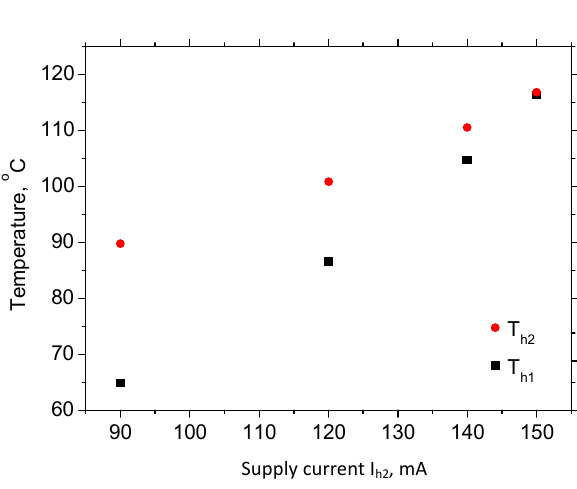
Figure 5. Temperature of both heaters versus the current through the larger heater I h1 when the current of the smaller heater I h2 is kept constant (80 mA).